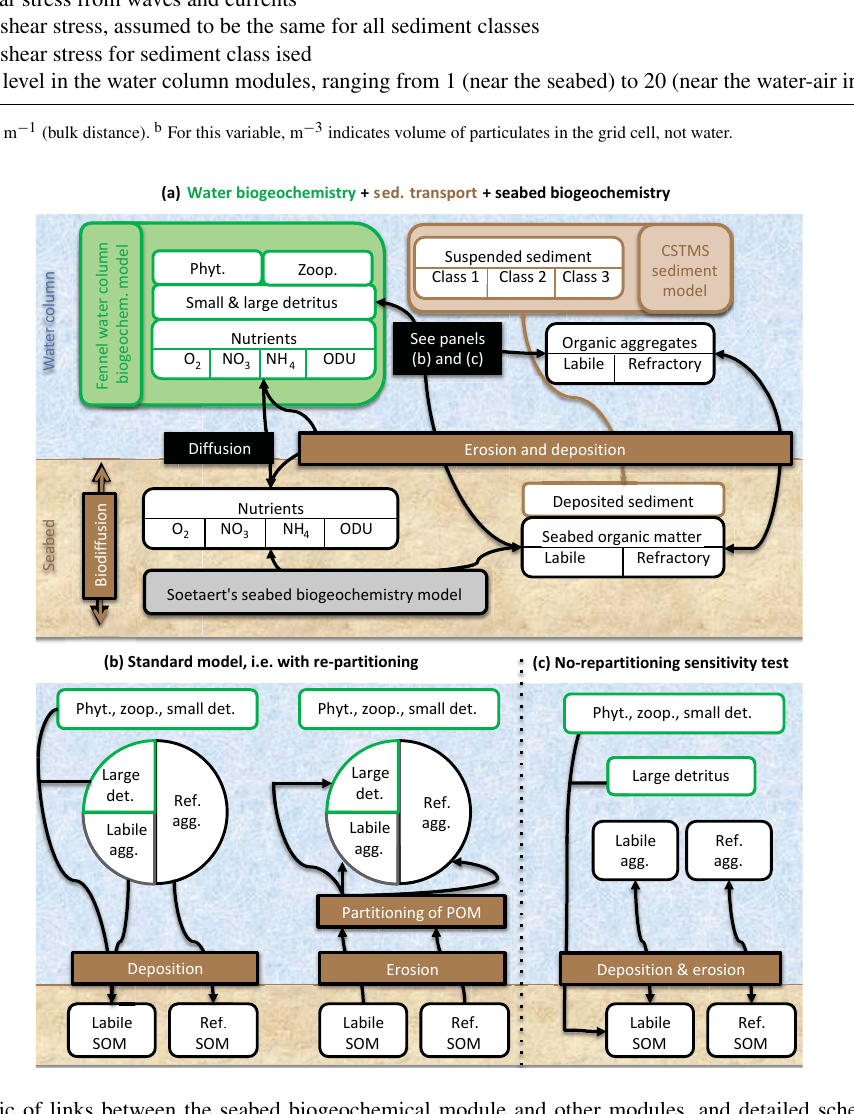
Figure 2. (a) Schematic of links between the seabed biogeochemical module and other modules, and detailed schematics of particulate organic matter partitioning for the (b) standard model run and (c) no-repartitioning sensitivity test. The colors of the boxes and labels indicate processes associated with sediment transport (brown), water-column biogeochemistry (green), and seabed biogeochemistry and model coupling (black). Abbreviations for this figure represent sediment (Sed.), biogeochemistry (Biogeochem.), phytoplankton (Phyt.), zooplankton (Zoop.), detritus (Det.), seabed organic matter (SOM), aggregates (Agg.), labile (Lab.), and refractory